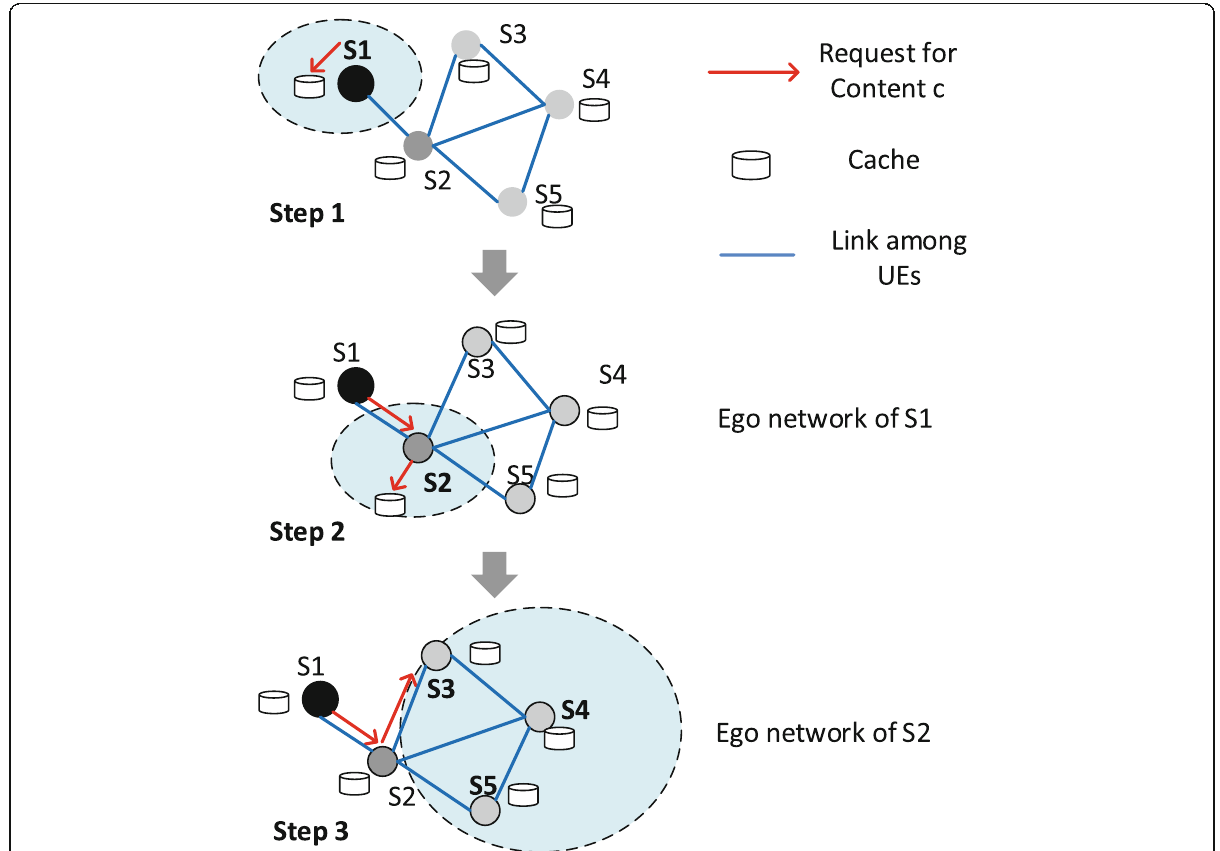
Fig. 7 A typical process of content search model of UE S1 in the UE